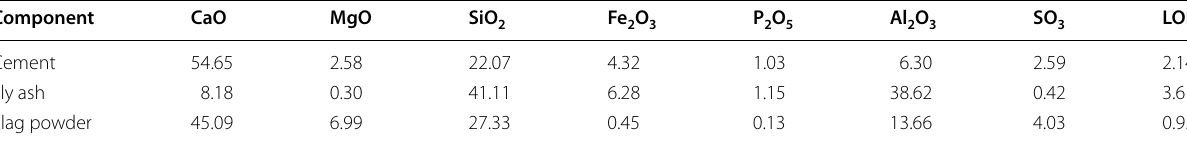
Table 1 Chemical composition of cementitious materials (%) Component CaO Cement Slag